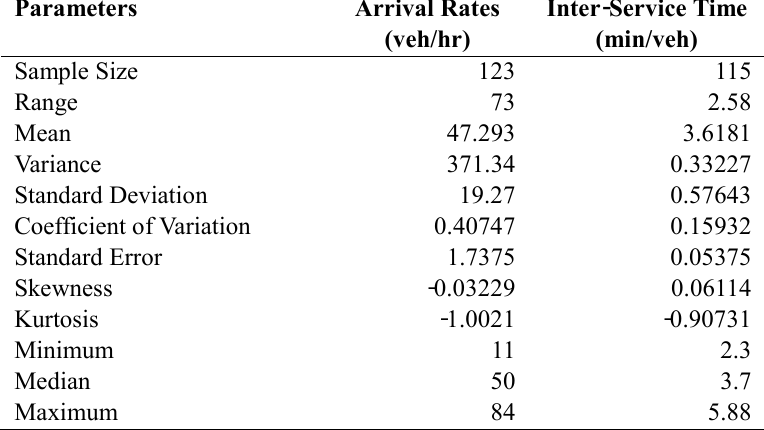
Descriptive Statistics of Queuing